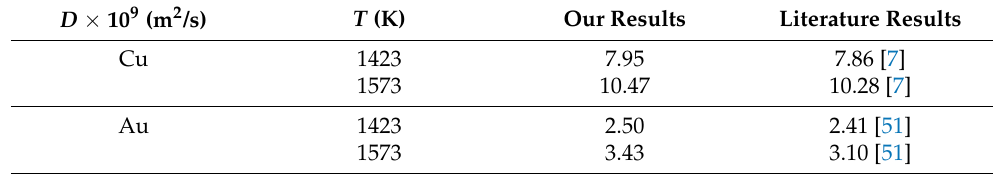
Table 4. Self-diffusion coefficients of Cu and Au in liquid Al 80 -Cu 20 and Al 80 -Au 20 alloys, respectively, at T = 1423 K and T = 1573 K calculated in the present work in comparison with the experimental [7] and MD-simulation [51] results for Al 80 -Cu 20 and Al 80 -Au 20 alloys, respectively. D × 10 9 (m 2 /s) T